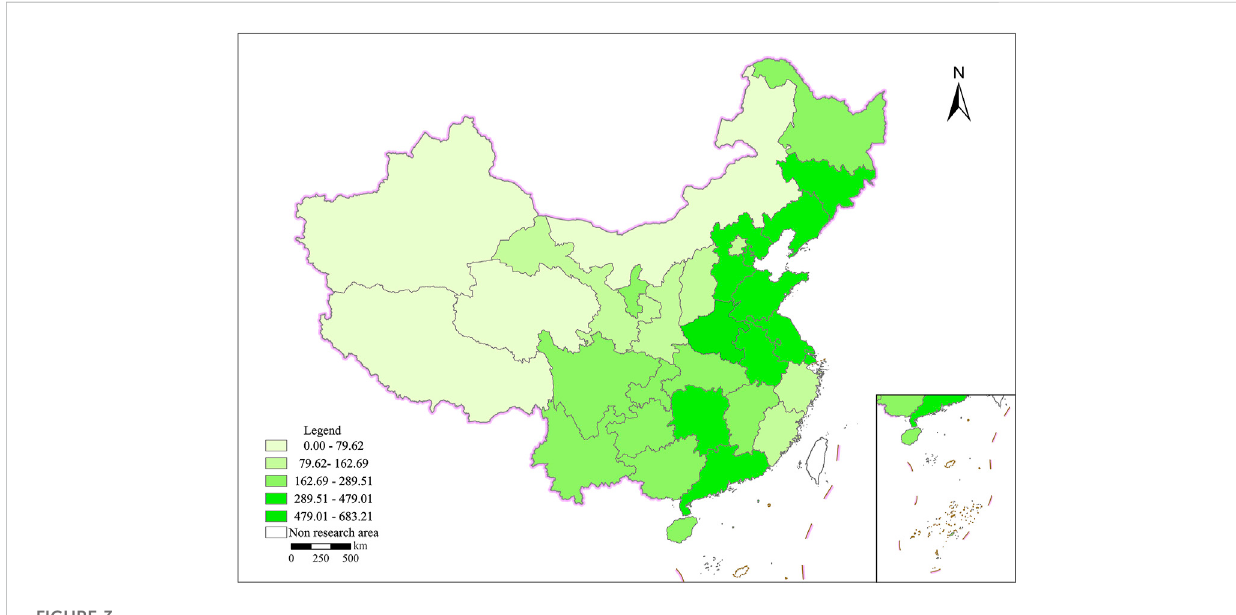
FIGURE 3 Distribution of biomass energy density per unit of land area in 2020.